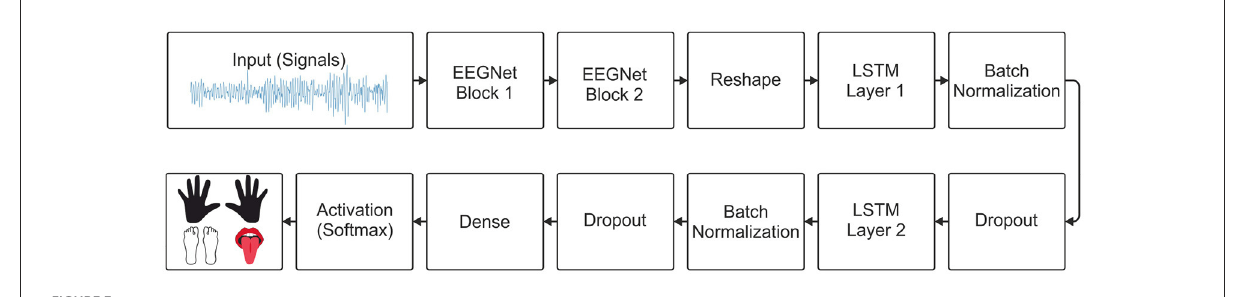
FIGURE3 Architecture of the EEGNet-LSTM neural